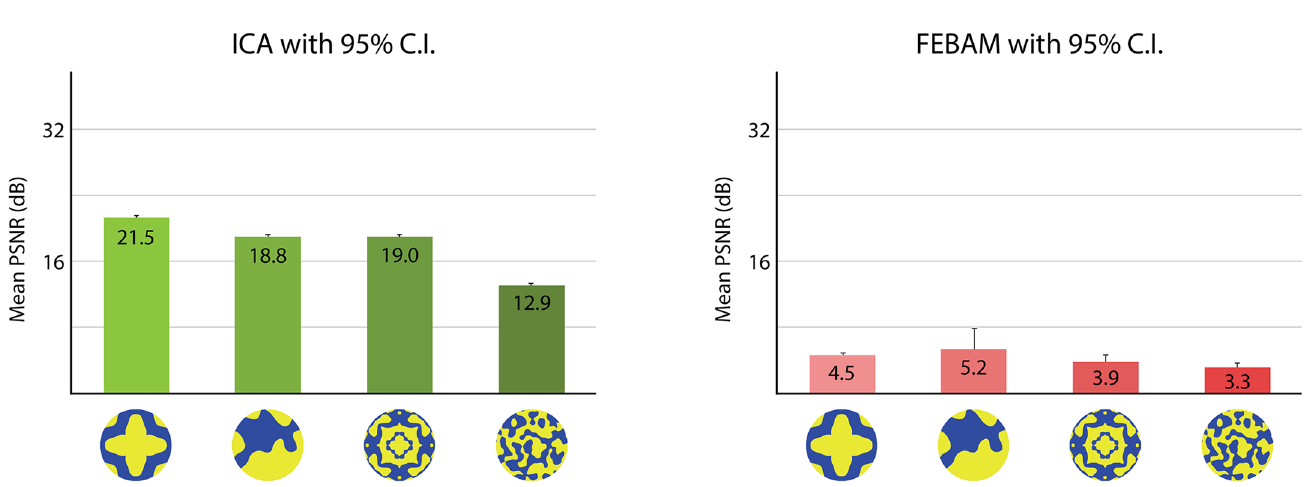
Fig 6. PSNR reconstruction values for 4-axis symmetric and asymmetric patterns. Error bars show 95% confidence intervals. The figure shows test patterns in their original form, as used in the behavioural experiment.